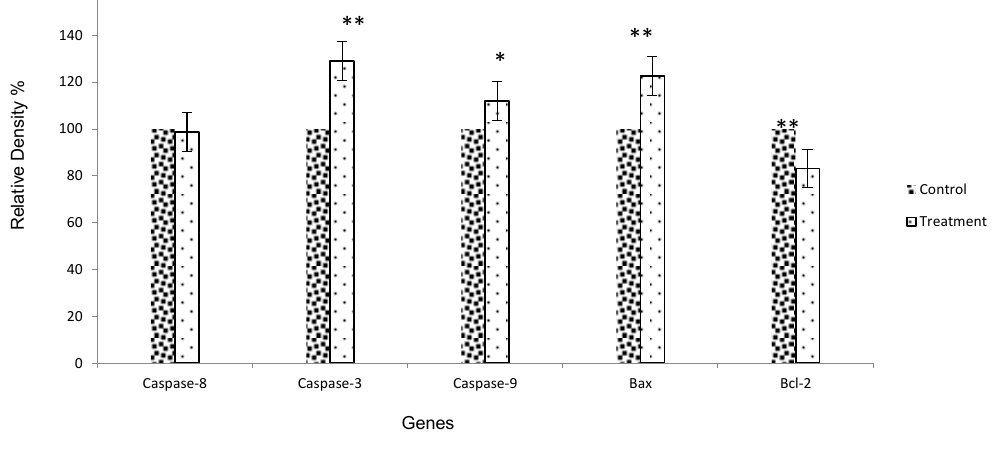
Figure 10. Diagram of apoptosis gene expression, * p < 0.05, ** p <